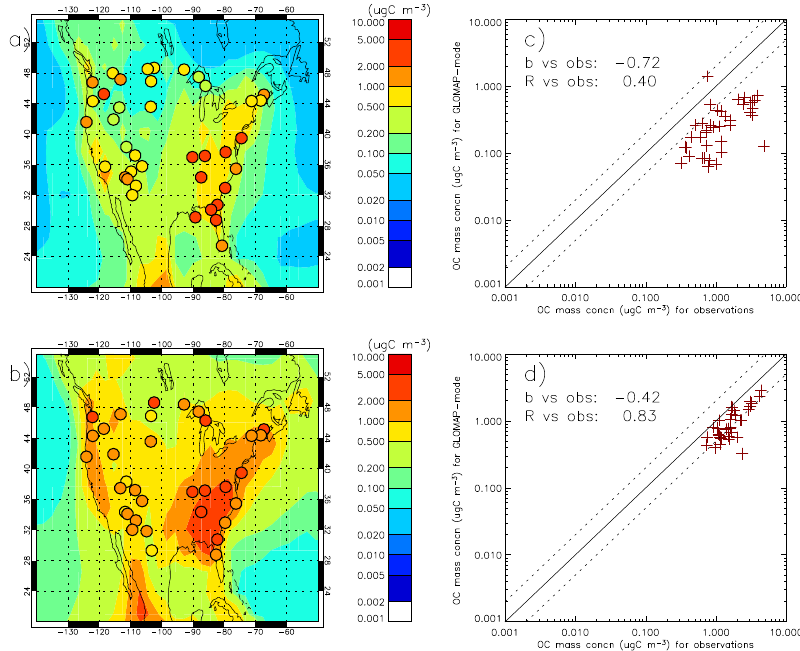
Fig. 7. Maps of simulated annual-mean organic carbon concentration in the lowest model level over North America for (a) December and (b) June with observations from IMPROVE sites over-plotted. Scatter plots for the model (y-axis) compared to the observations (x-axis) are shown in panels (c) and (d) with b and R values also shown. Observations are for the year 2000 with only sites where the height above sea-level is within 250m of that calculated for the lowest model level included.